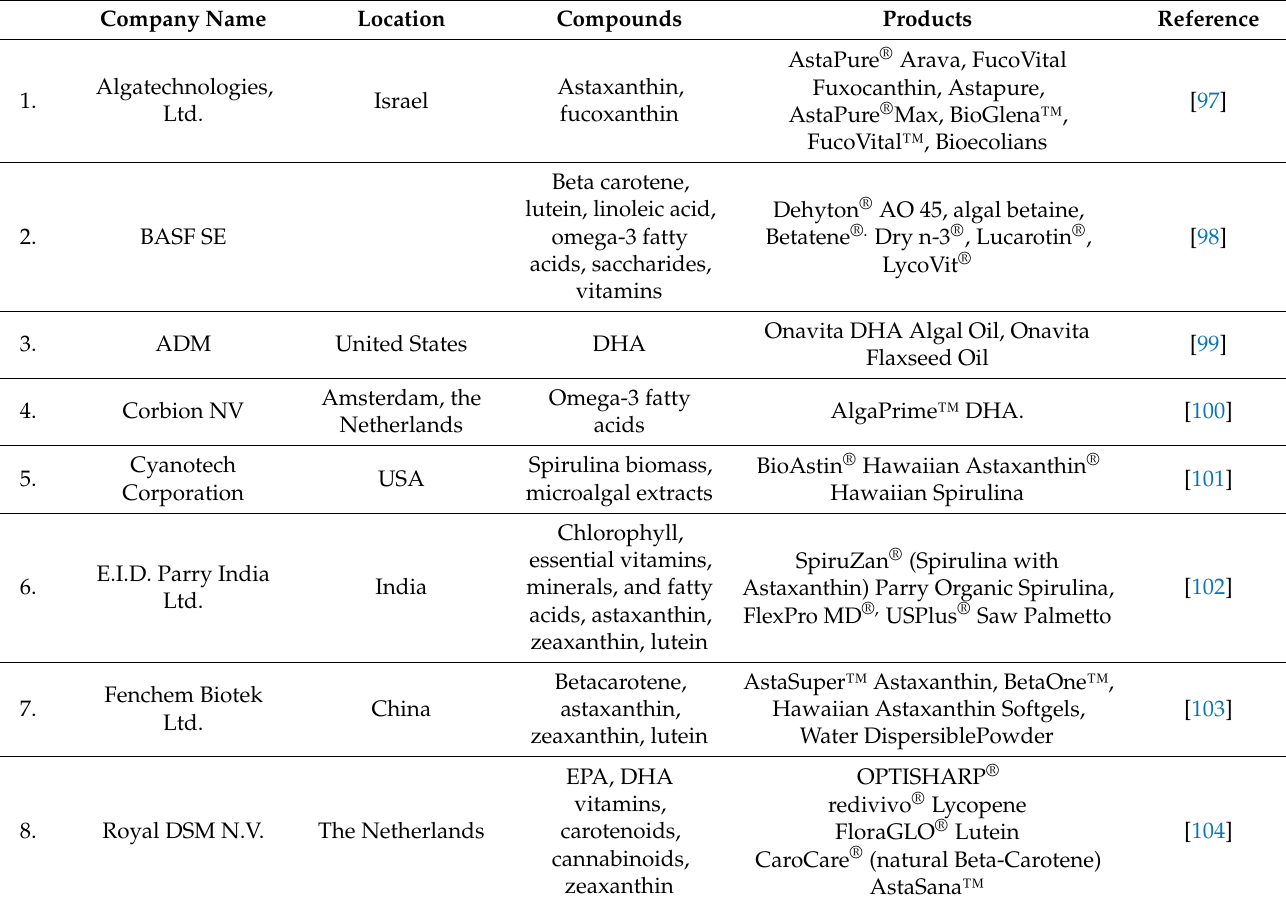
Table 2. Algal Companies in Global Market with their biorefinery